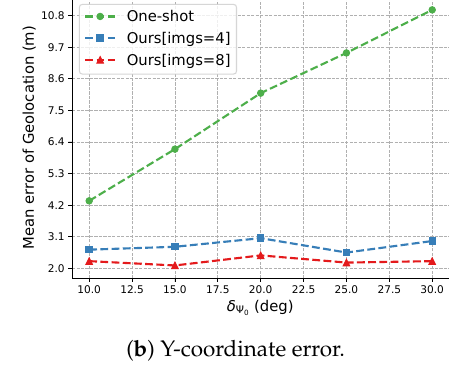
( b ) Y-coordinate error.